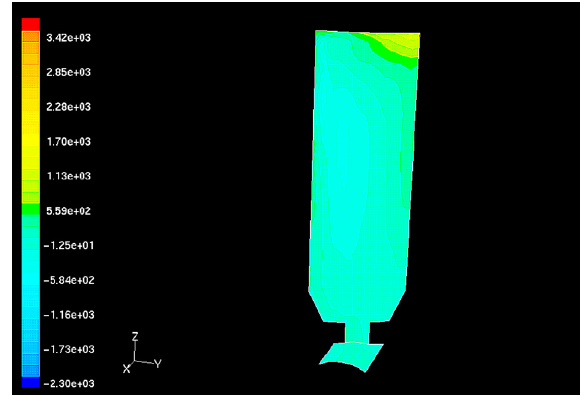
Figure 22: Dynamic pressure on the suction side with radiator (unit in Pascal).